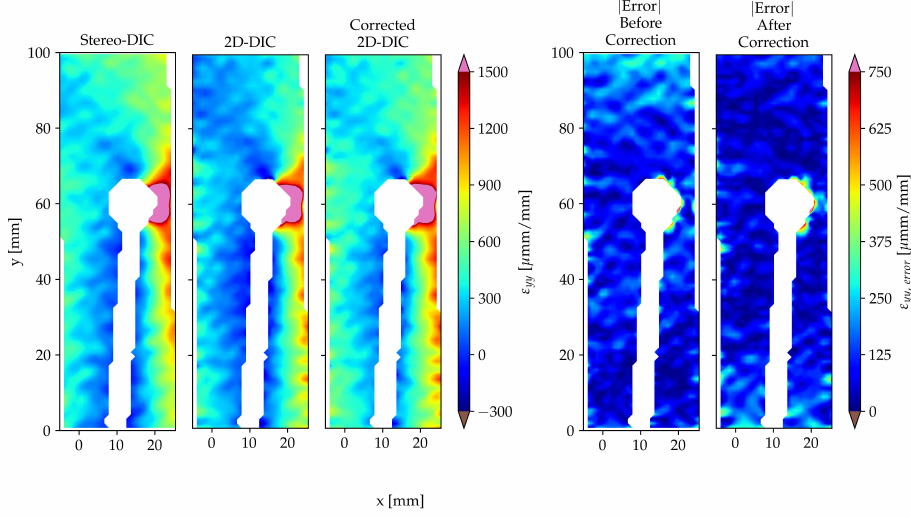
Figure 15. Contour plots of the stereo-DIC, 2D-DIC, corrected 2D-DIC and error data for the 700th image of Test